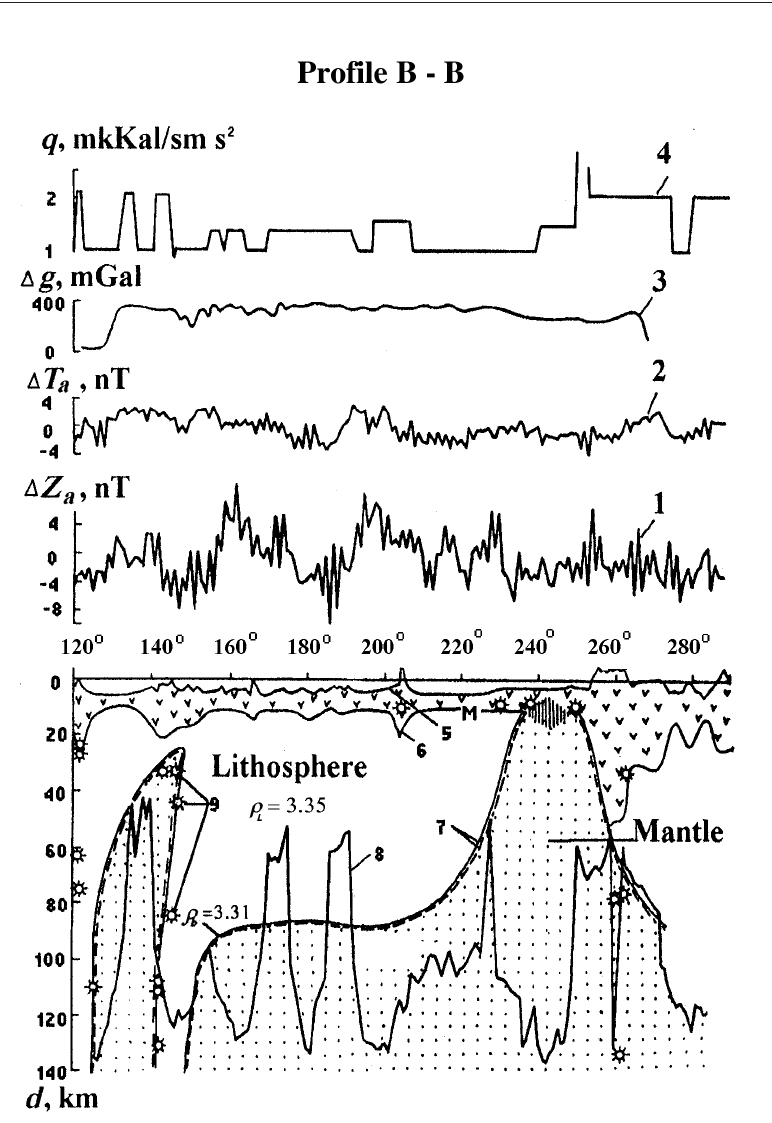
Fig. 5. Complex geophysical cross-section of the lithosphere for the Pacific Ocean region along ϕ= 20°N: 1 – vertical component of the magnetic anomaly field from the MAGSAT satellite data; 2 – scalar of the magnetic anomaly field from the MAGSAT satellite data; 3 – values of the gravity field in Glenni reduction; 4 – heat flow at the ocean bottom; 5 – depth of the ocean bottom surface; 6 – depth of the Moho surface from the results of in- terpretation of seismic sounding; 7 – depth of the lower boundary of the lithosphere from the data of the gravity field; 8 – depth of the lower boundary of the magnetically active layer of the lithosphere from the data of satellite magnetic measurements based on the technique proposed by Serkerov (1991); 9 – location of the earthquake hypocenters for the period of the MAGSAT satellite measurements from electronic catalogue of the seismological data of International Geophysical Center of the data of Russian Academy of Sciences. Curves 3, 7 are drawn up from the data of Gainanov et al. (1998): ρ L – density of lithosphere; ρ b – density on the lower boundary of the lith- osphere from the data of Gainanov et al. (1998); curves 4, 5, 6 are drawn from the data of Gorshkov et al.